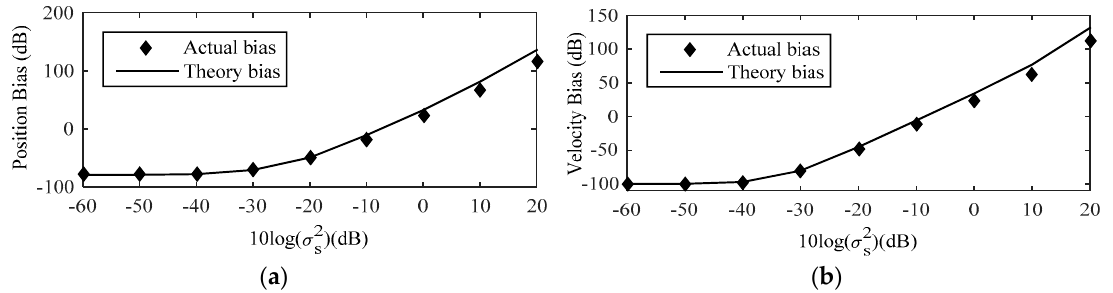
Figure 7. Comparison between theoretical and actual bias of near-field source location estimate by MLE. ( a ) Position Bias; ( b ) Velocity Bias.